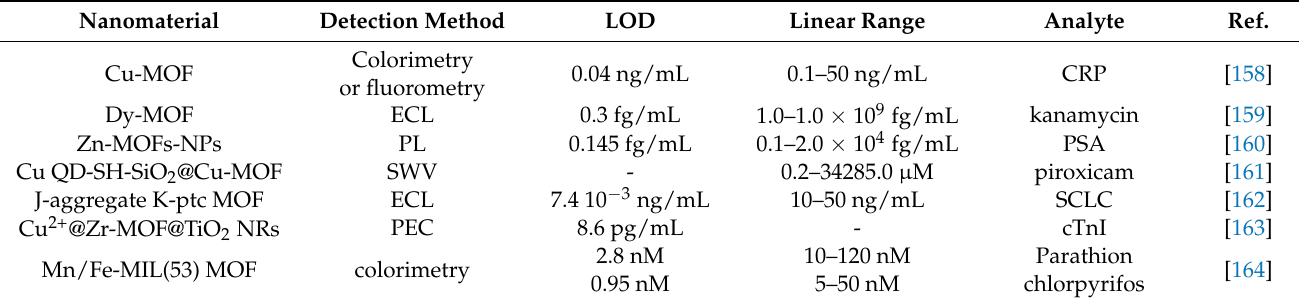
Table 7. MOFs biosensors for biomedical